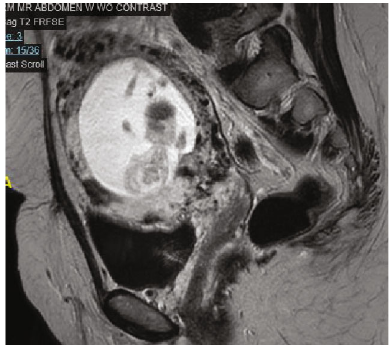
Figure 3: MRI imaging with radiology report eccentric intrauterine pregnancy associated with the c-section scar, extending into the posterior-lateral left adnexa where the placenta is uncovered from the myometrium. The placenta abuts the bladder without evidence for direct invasion.